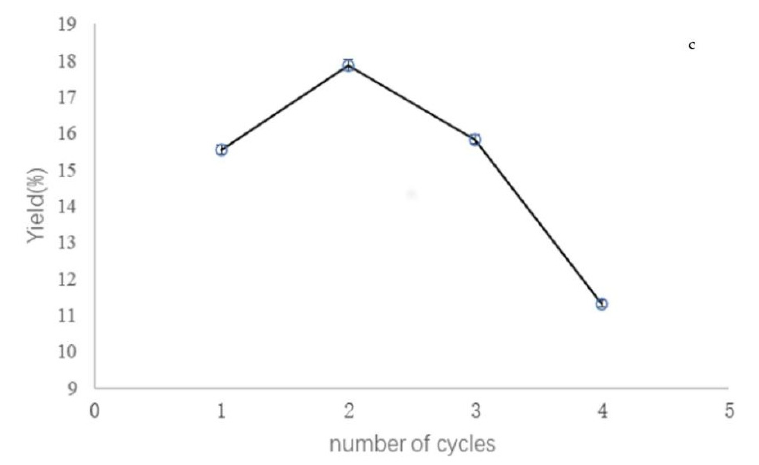
Figure 1. Effects of different extraction parameters on extraction yield of crude polysaccharide from mushroom ( a ) extraction temperature, °C; ( b ) extraction time, min; ( c ) number of cycles.